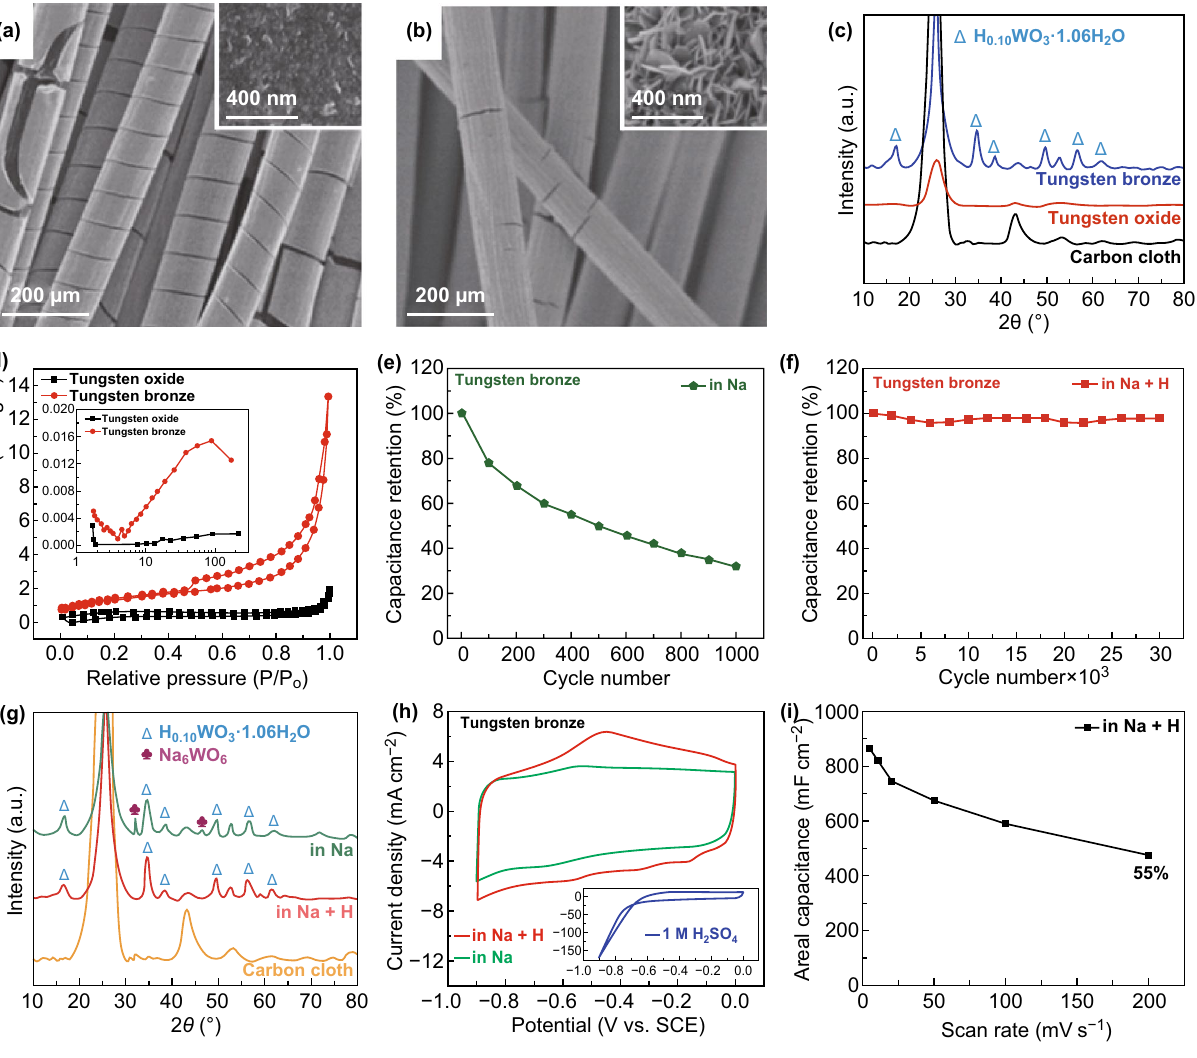
Fig. 24 a , b SEM images of a electrodeposited tungsten oxide and b tungsten bronze films on carbon cloth. c XRD patterns of tungsten oxide, tungsten bronze, and carbon cloth. d N 2 adsorption–desorption isotherms of tungsten oxide and tungsten bronze. Inset: pore size distributions. e , f Cycling stability of tungsten bronze in e 1 M Na 2 SO 4 and f Na 2 SO 4 /H 2 SO 4 (1 M/0.01 M) mixed aqueous electrolytes. g XRD patterns of tung‑ sten bronze after cycled in Na 2 SO 4 and Na 2 SO 4 /H 2 SO 4 . h CV curves of tungsten bronze in Na 2 SO 4 (green), Na 2 SO 4 /H 2 SO 4 (red), and H 2 SO 4 (blue) aqueous electrolytes. i Rate capability of tungsten bronze in Na 2 SO 4 /H 2 SO 4 . Adapted from Ref. [234] with